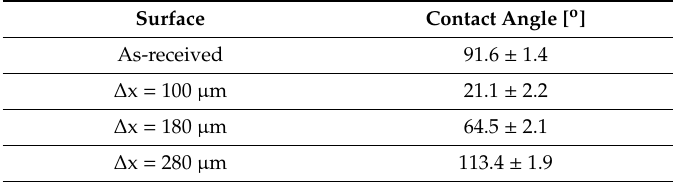
Table 3. Wettability of as-received and laser-textured Ti-6Al-4V surfaces.